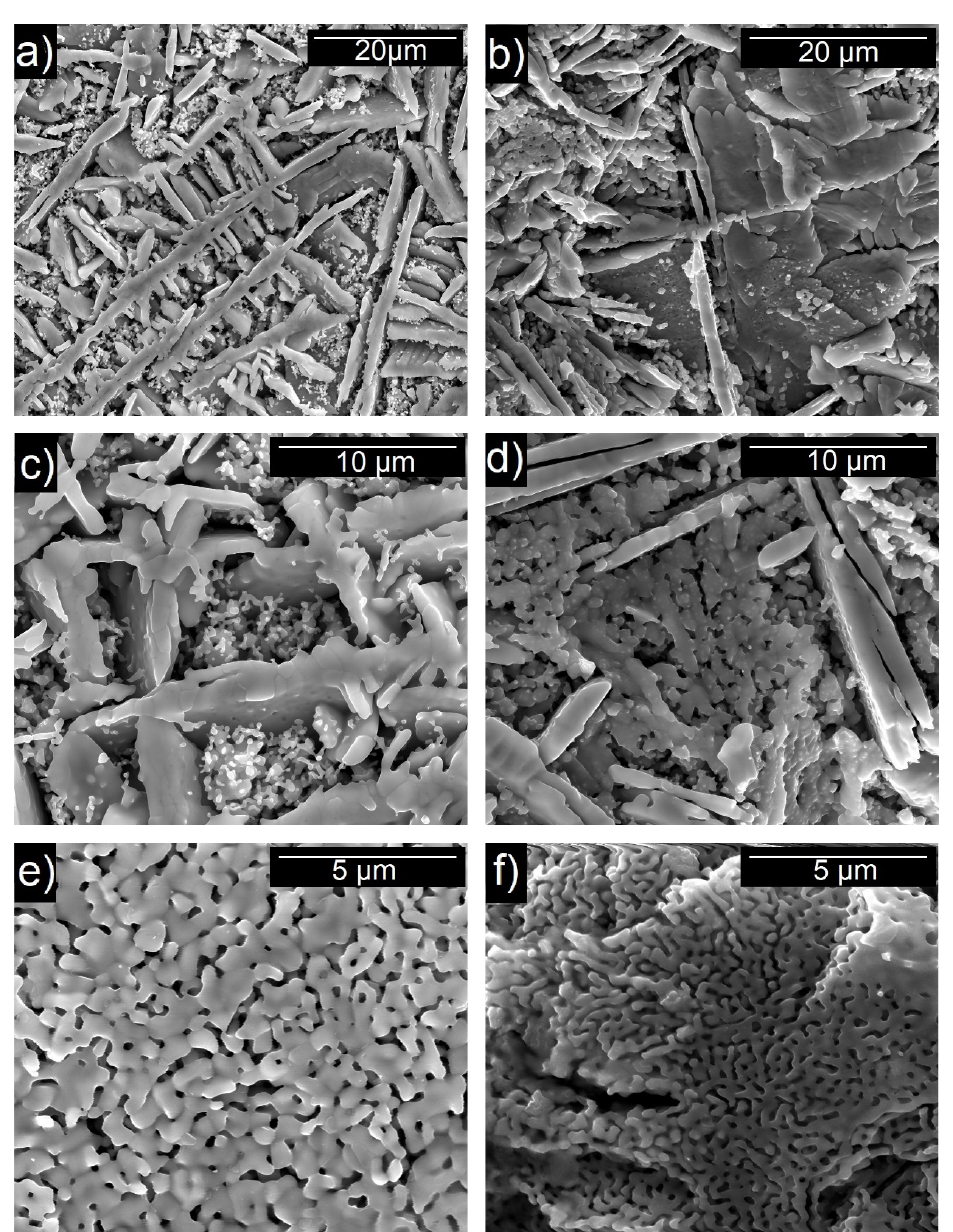
Figure 2. Scanning electron micrographs of the porous TiMo alloy obtained by dealloying at 900 ◦ C for 5 min ( a , c , e ) and 800 ◦ C for 10 min ( b , d , f